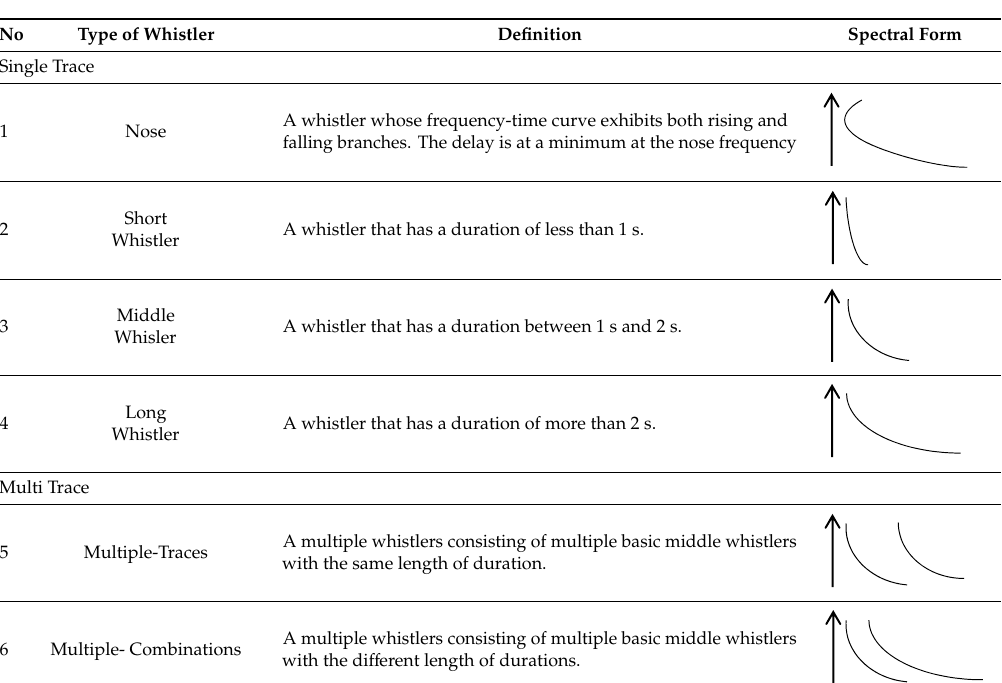
Table 1. Arase whistler map: Type and principal definitions of lightning whistlers partially adapted from the original whistler atlas by Helliwell [17]. 188